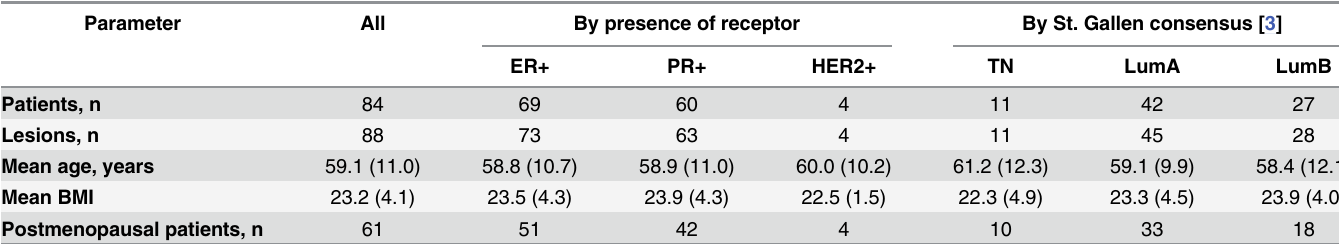
Table 1. Patient and subtype